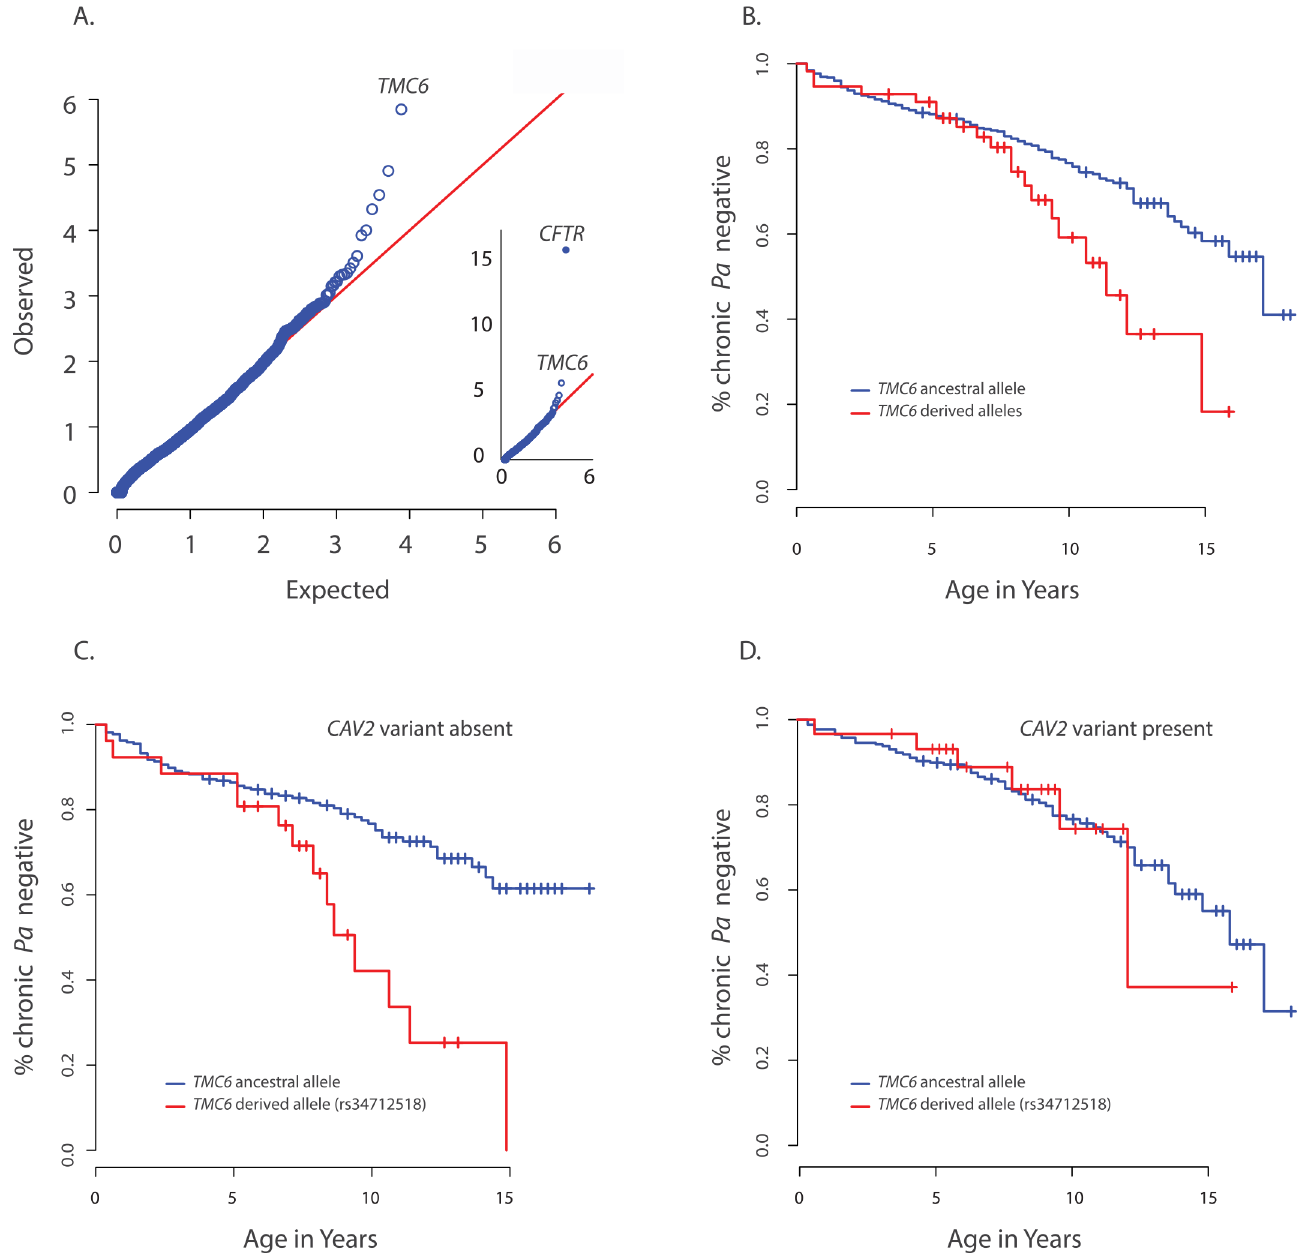
Fig 2. Primary results for TMC6 from exome discovery and validation phases and its interaction with CAV2 . ( A ) QQ-plot of p-values from the discovery analysis of exomes from 65 CF individuals with late onset chronic P . aeruginosa infection versus exomes from 3275 non-lung disease European American population control exomes. P-values are from the SKAT-O test with the small sample adjustment applied to non-synonymous variants grouped by gene to discover genes with differing distributions of these variants between groups. The most significant gene (highest point) is CFTR (p < 1x10 -16 ), followed by TMC6 (p = 9.5x10 -7 ). ( B ) Kaplan Meier curves for age-of-onset of chronic P . aeruginosa in individuals in validation cohort with cystic fibrosis with at least one TMC6 rs3412518 derived allele versus those with ancestral alleles. Individuals with at least one TMC6 rs3412518 derived allele had a higher risk for early onset chronic P . aeruginosa and this risk increased significantly over time (p = 0.01 for age interaction; HR = 5.2 at age 10, p = 0.00046, 95% CI = [2.1 – 43.0]). ( C ) Kaplan Meier curves for age-of-onset of chronic P . aeruginosa in individuals in validation cohort with cystic fibrosis showing TMC6 risk groups among individuals without the CAV2 rs8940 protective (derived) allele. Individuals with at least one TMC6 rs34712518 derived allele had higher risk for early onset and this risk increased significantly over time (HR = 12.1 at age 10, p = 2.6x10 -5 , 95% CI = [3.8 – 38.8]). ( D ) Kaplan Meier curves for age-of-onset of chronic P . aeruginosa in individuals in validation cohort with cystic fibrosis showing TMC6 risk groups among individuals with the CAV2 rs8940 protective (derived) allele. There was no significant difference in risk between individuals with and without TMC6 rs34712518 among these children with the CAV2 protective allele (HR = 2.1, p = 0.41, 95% CI = [0.38 – 11.3]).